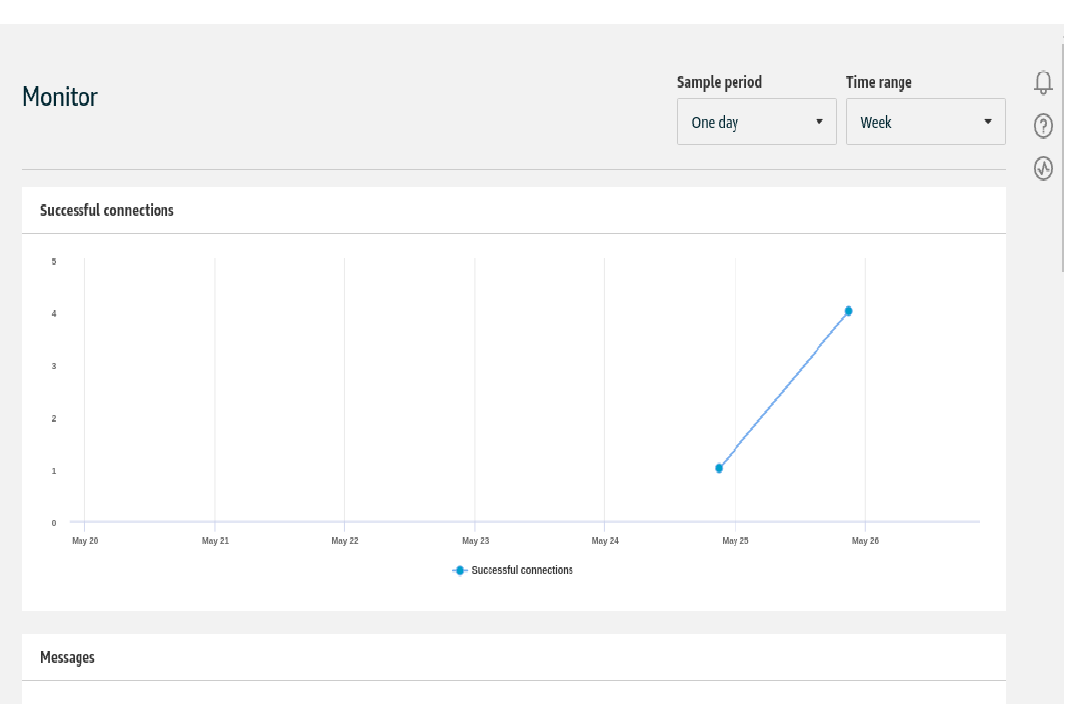
Figure 6. Successful communication and data exchange between nodes. The x-axis represents days of the month, and the y-axis the number of connections.